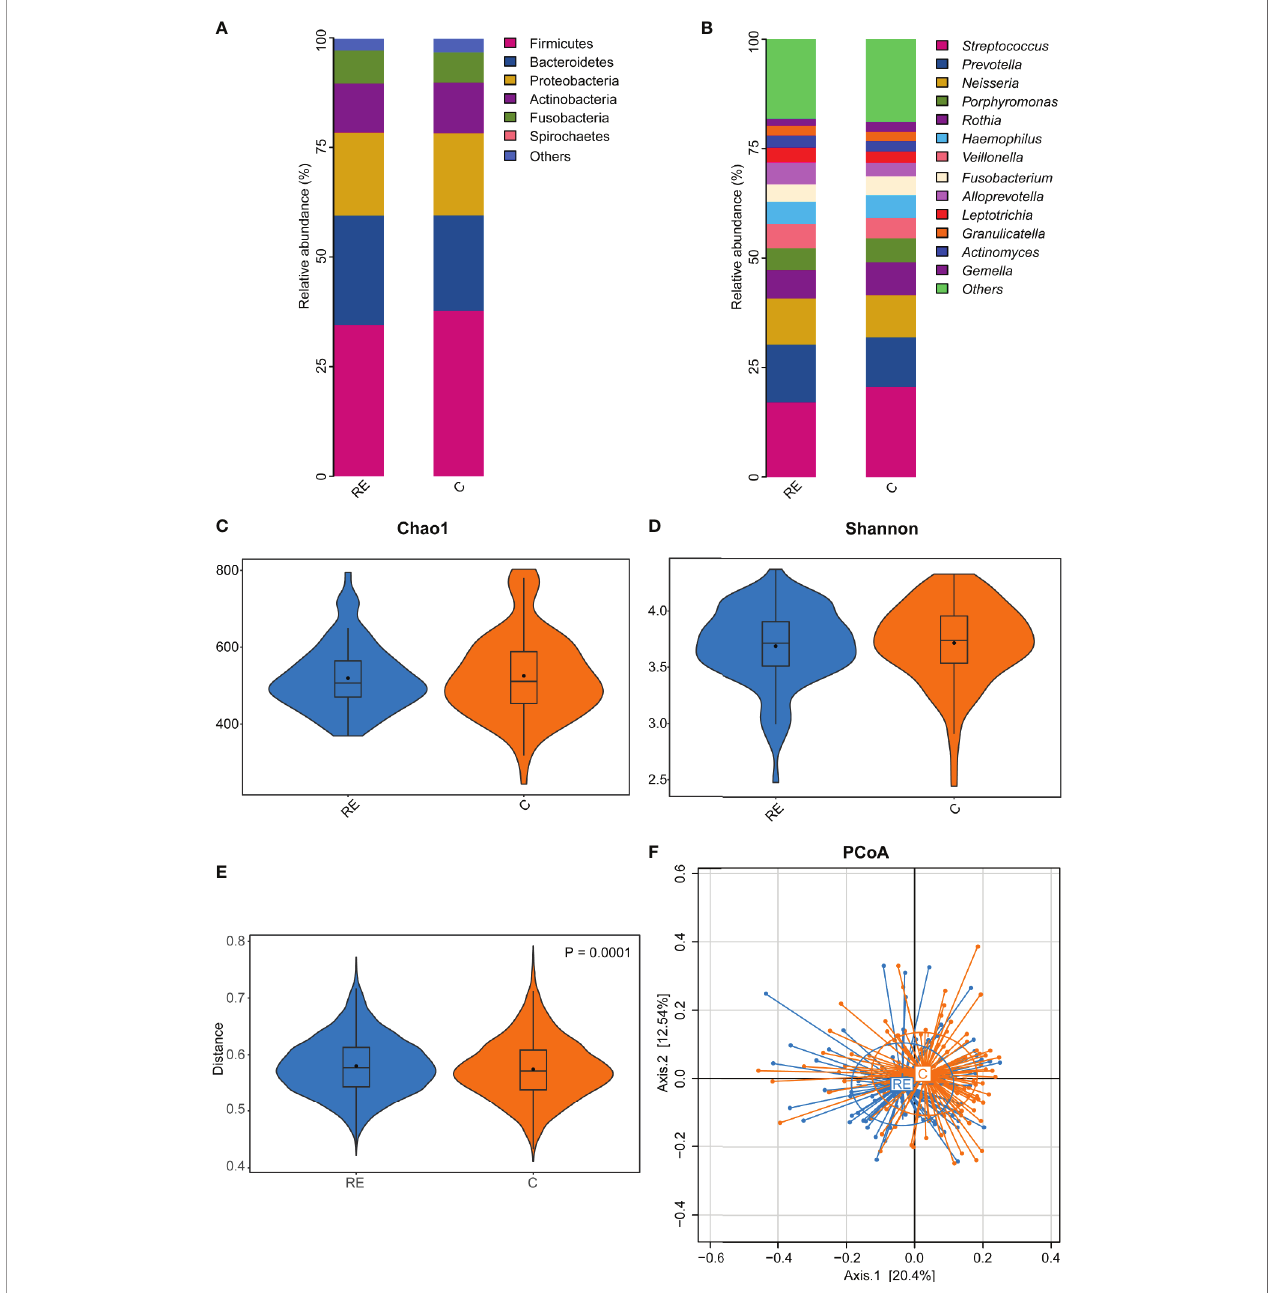
FIGURE 1 | The effect of re fl ux esophagitis on the human oral microbiota. The oral bacterial community composition in re fl ux esophagitis patients (RE group) and healthy people (C group) at the phylum level (A) , and the genus level (B) . The alpha diversity of the RE group tended to be lower than that of the C group, but it was not signi fi cantly different, P > 0.05 (C, D) . The beta diversity of RE group was signi fi cantly higher than that of the C group, R 2 = 0.009, P = 0.0001 (E, F)